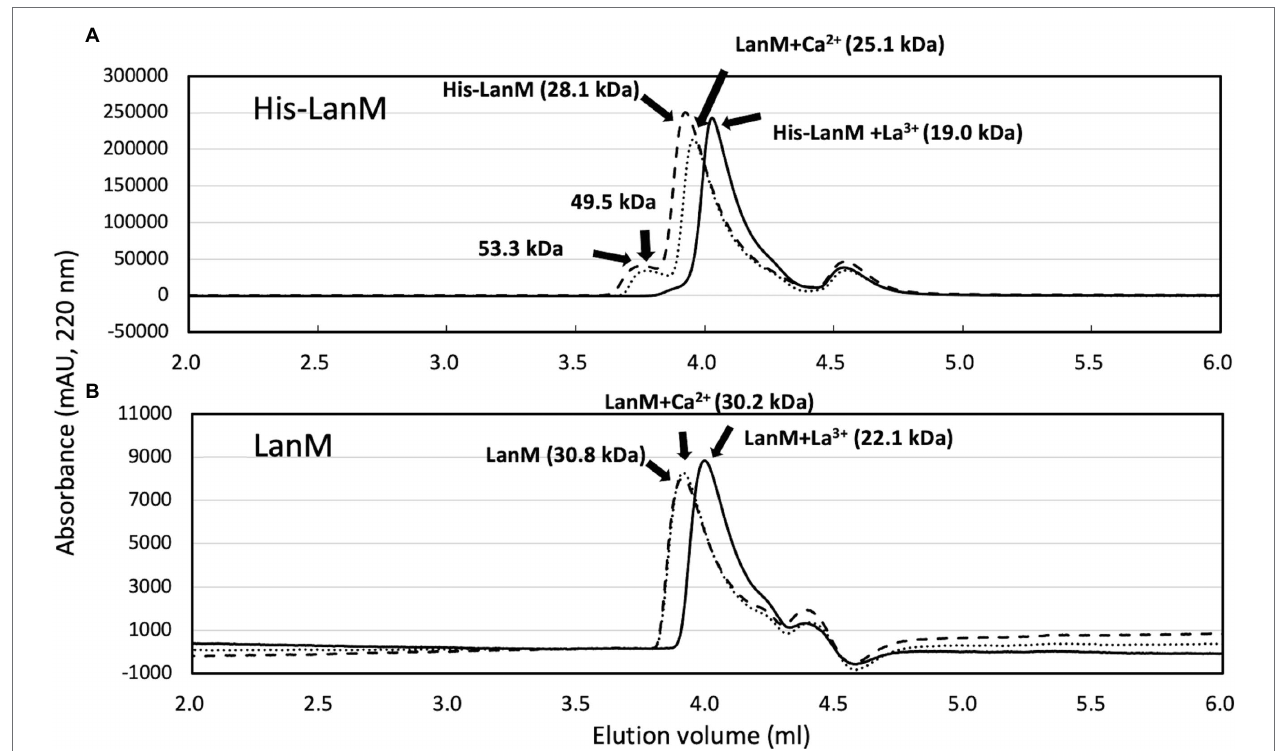
FIGURE 2 | (A) Gel filtration analysis of His-LanM. The purified His-LanM (86 μ M, 100 μ l) was subjected to gel filtration analysis. Lines, absorbance at 220 nm; dashed line, His-LanM; solid line, His-LanM mixed with 3.4 mM LaCl 3 ; and dotted line, His-LanM mixed with 3.4 mM CaCl 2 . (B) Gel filtration analysis of LanM. The purified LanM (43 μ M, 80 μ l) obtained by GST-cleavage of GST-LanM was mixed with 1.7 mM CaCl 2 or 1.7 mM LaCl 3 and subjected to gel filtration. Lines, absorbance at 220 nm; dashed line, His-LanM; solid line, His-LanM mixed with La 3+ ; and dotted line, His-LanM mixed with Ca 2+ . Protein molecular weight analysis was carried out with separately analyzed standard proteins of chicken egg albumin, 45 kDa; bovine milk α -lactalbumin, 14.2 kDa; cytochrome c 12.4 kDa; and aprotinin 6,511 Da.